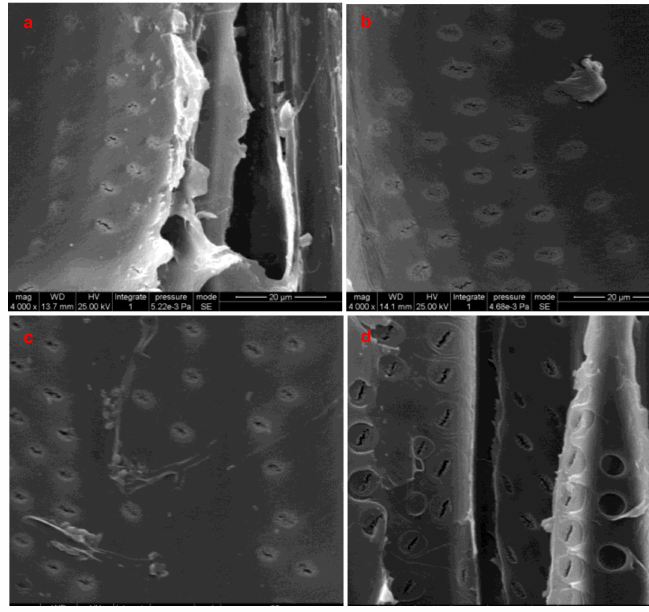
Figure 8. SEM micrographs of wood after conventional drying ( a : 50 ◦ C / 60% RH) and 1 h of SCD at di ff erent pressures ( b : 10 MPa, c : 20 MPa, d : 30